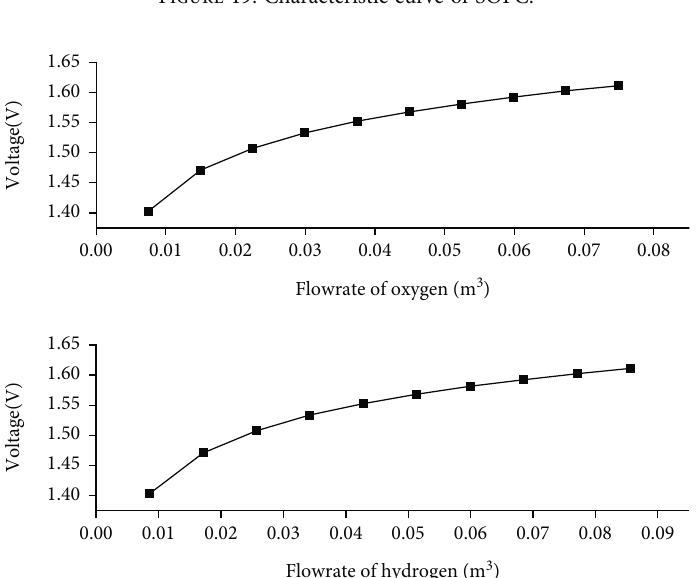
Figure 19: Characteristic curve of SOFC.